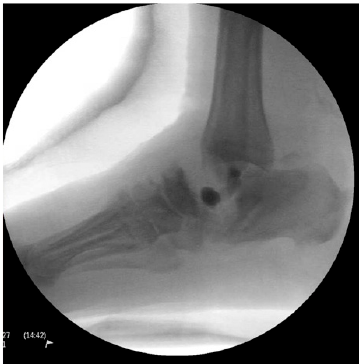
Figure 6. Postoperative image in the cast.